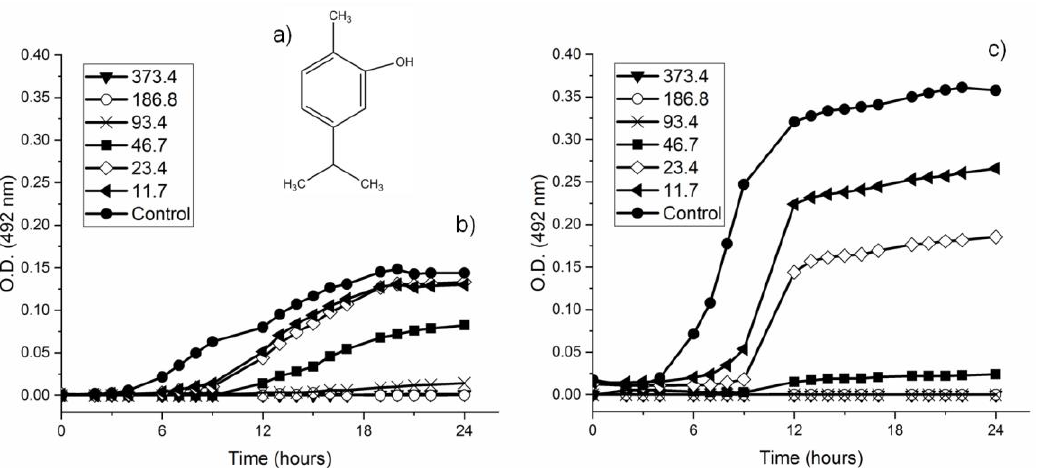
Figure 1. Chemical structure of CAR ( a ); growth curves of S. mutans ( b ) and S. sanguinis ( c ) against different concentrations of CAR ( µ g/mL) and Control (no treatment).